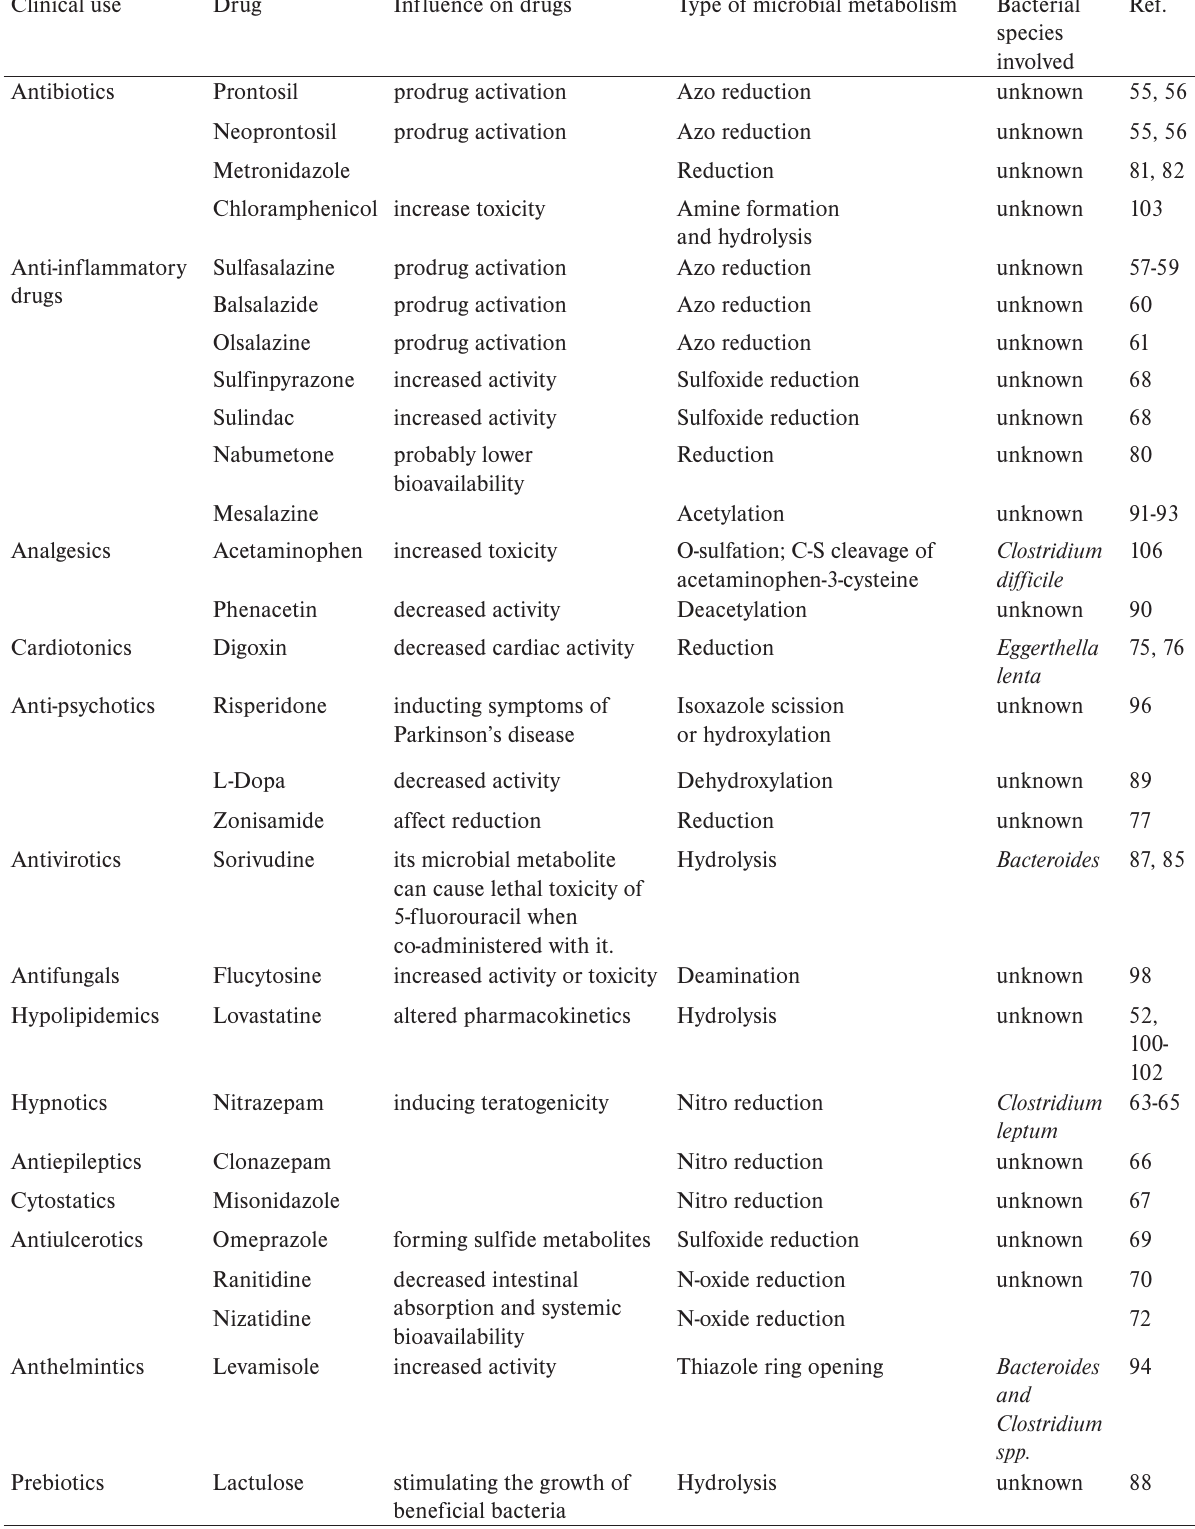
Table 1. summary of drugs metabolized by gut